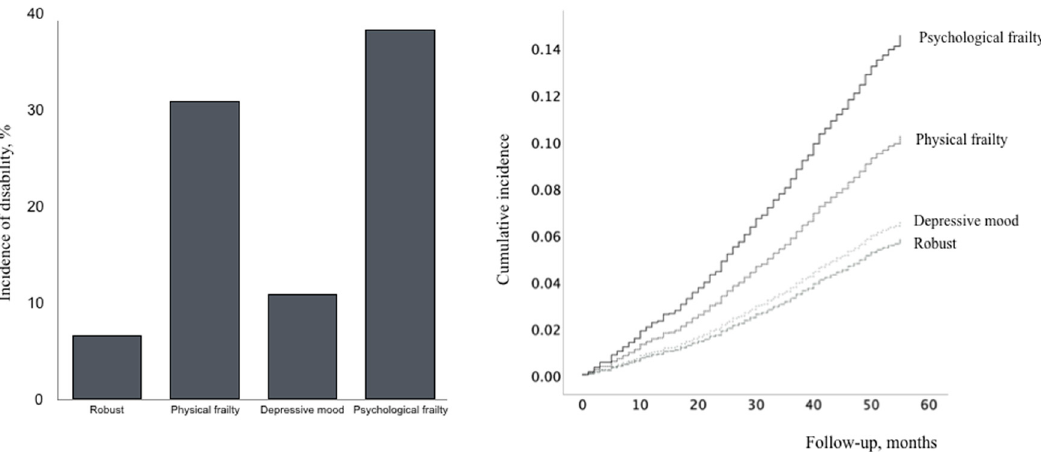
Figure 3. Cox proportional hazards regression models of disability incidence according to frailty status. Table 3. Hazard ratios for disability according to frailty status and confounding factors.